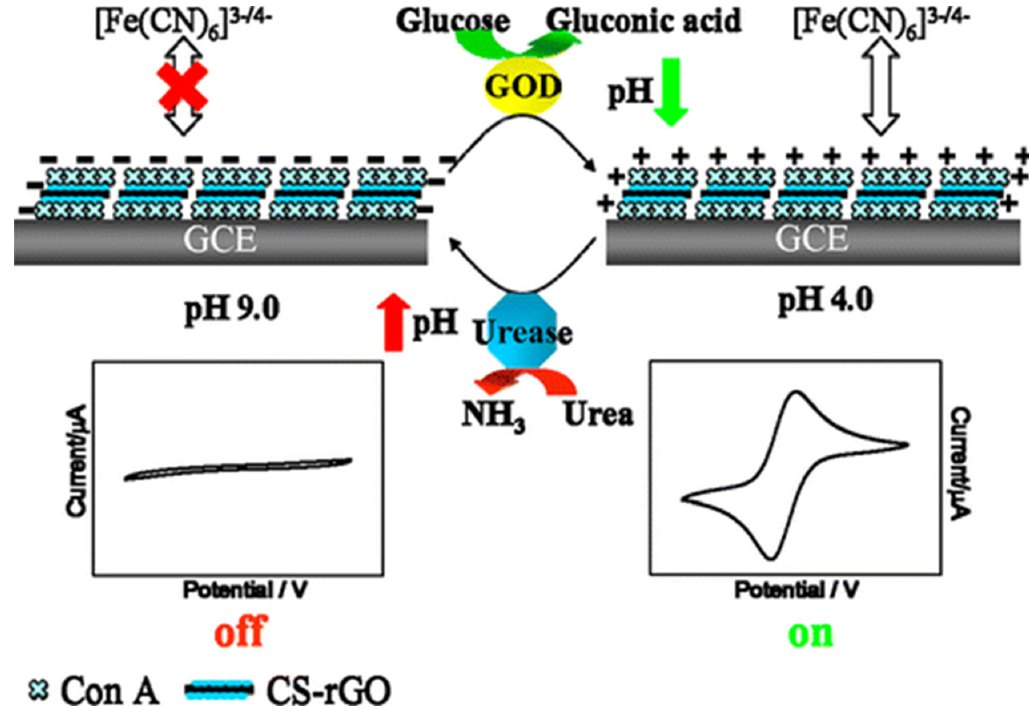
Figure 9. Schematic illustration of pH-switchable behavior of Fe(CN) 63 − on the ConA/CS-rGO/GCE triggered by the enzyme-catalyzed reactions [46].